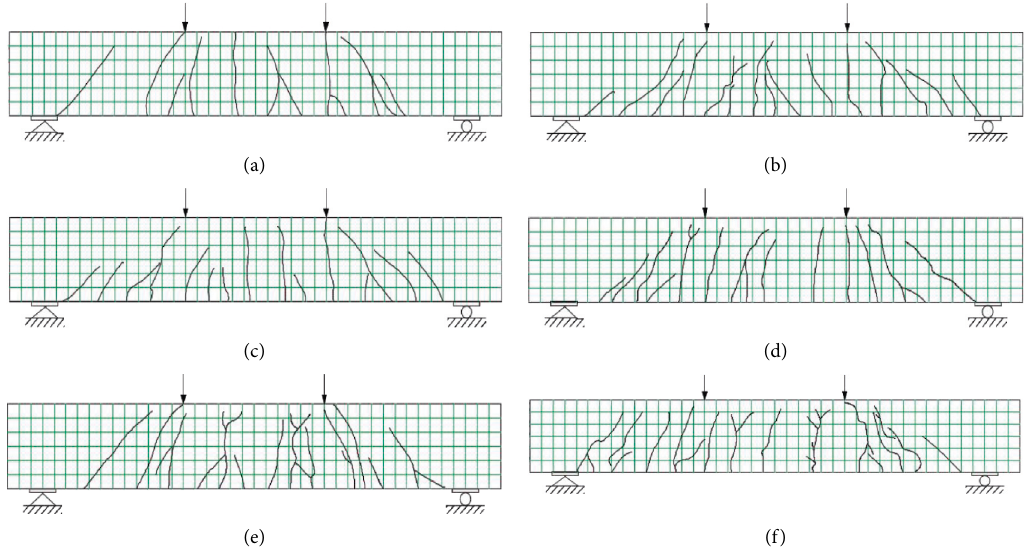
Figure 5: Crack distribution of the test beam. (a) BFRC1. (b) BFRC2. (c) BFRC3. (d) BFRC4. (e) BFRC5. (f)